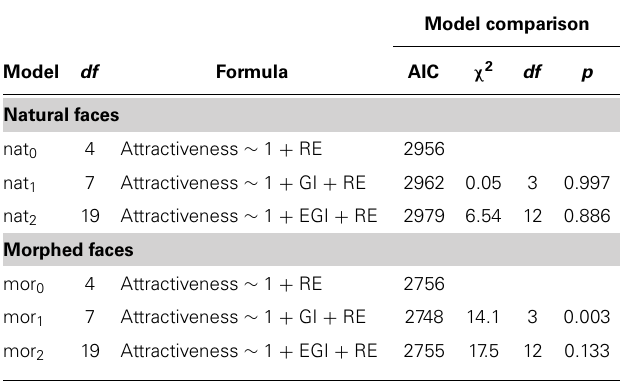
Table 1 | Comparison of nested linear mixed effects models (LMMs) fitted to subjective attractiveness ratings in Experiment 1.